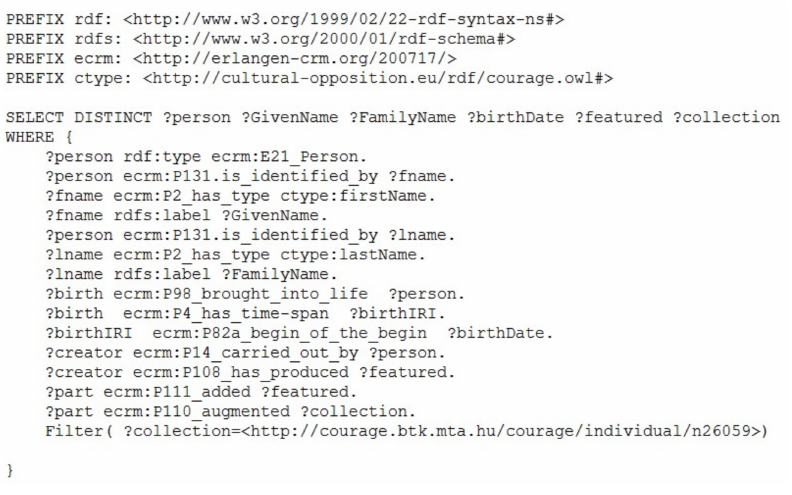
Figure 16. Sample query in